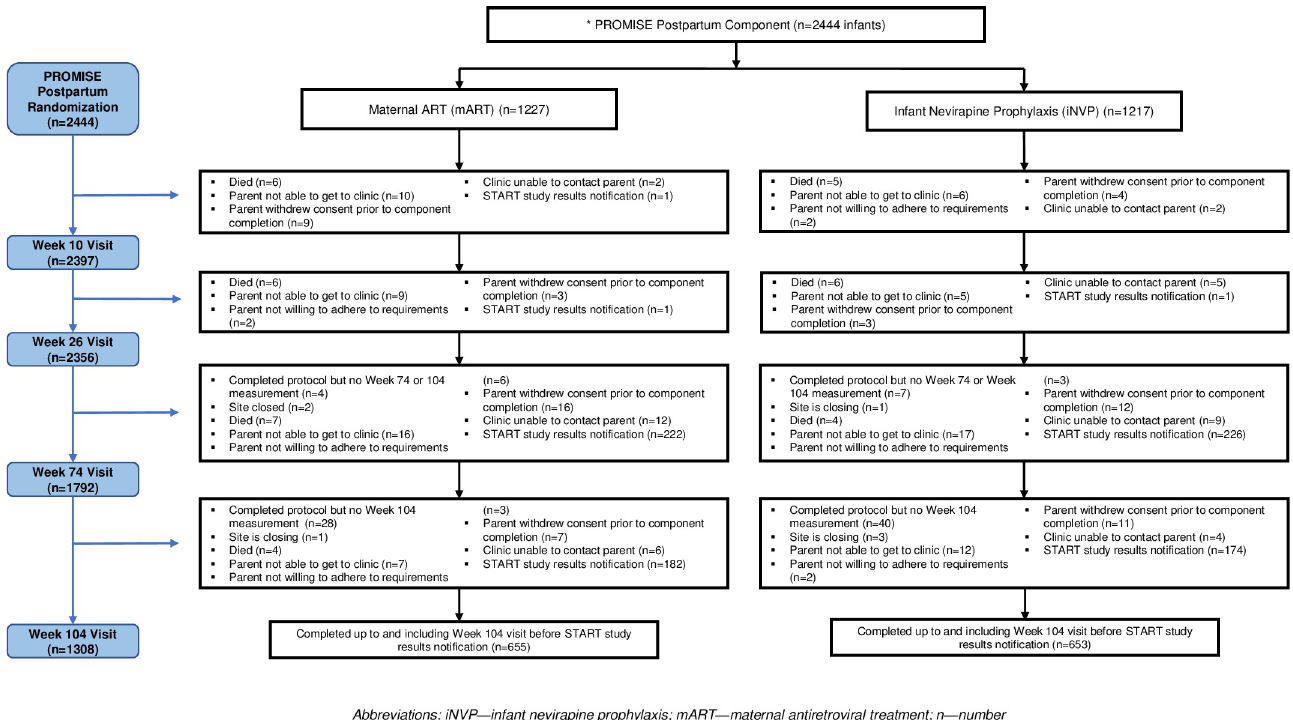
Fig 1. Participant flow diagram. There was no apparent difference in premature study discontinuation for reasons other than death; 23 in the mART arm (2% of 1,227 randomized) and 15 in the iNVP arm (1% of 1217) (p = 0.81). The median (Q1-Q3) follow-up in both arms was to 104 weeks of age (74–105), with a mean of 88 weeks. Most infants still breastfed (93.7% (95%CI: 92.6%, 94.6%)) at 26 weeks of age. The estimated median (Q1-Q3) duration of breastfeeding and, hence, postnatal ARV exposure was 70 weeks (56–82) and not different in both study arms. As previously reported [16], 14 breastfed infants acquired HIV infection during postnatal follow-up (7/1219 mother-infant pairs in the maternal ART arm and 7/1211in the infant NVP arm). https://doi.org/10.1371/journal.pone.0255250.g001 PLOS ONE | https://doi.org/10.1371/journal.pone.0255250 August 20,